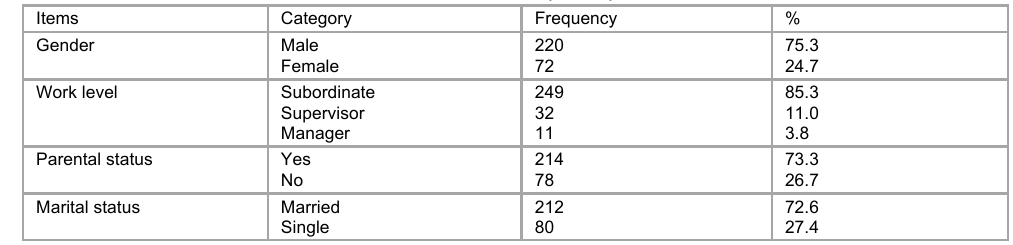
Characteristics of